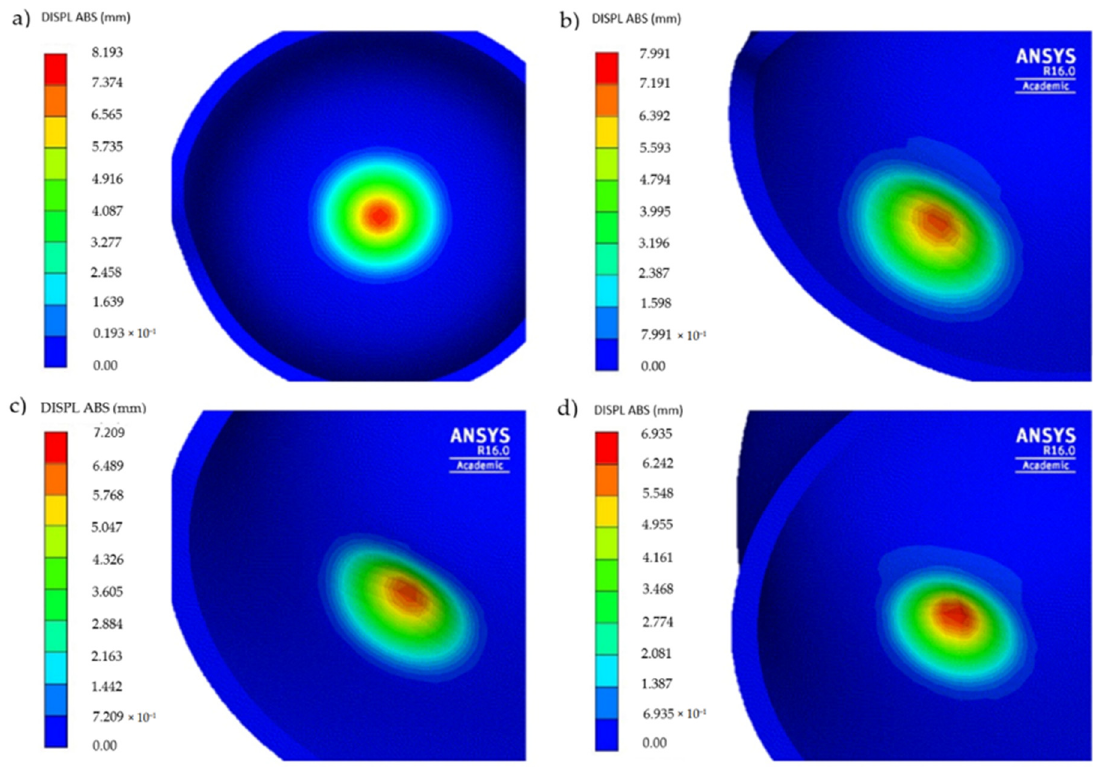
Figure 6. The deformation at interior surface of the helmet after ballistic impact of 9 mm FMJ bullet with a velocity of 358 m s − 1 ( a ) top, ( b ) front, ( c ) rear, and ( d )